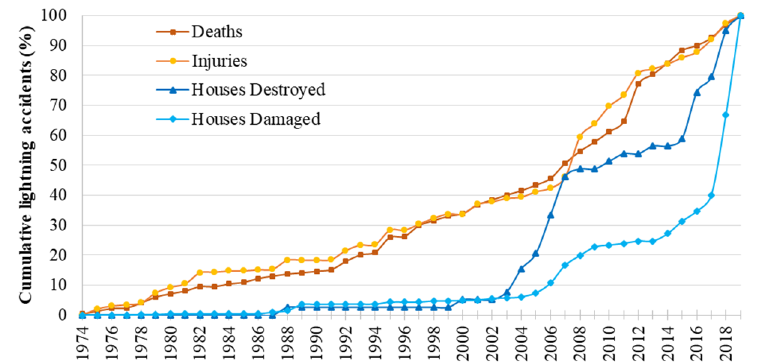
Figure 9. Cumulative lightning accidents (in %) in Sri Lanka, from 1974 to 2019.